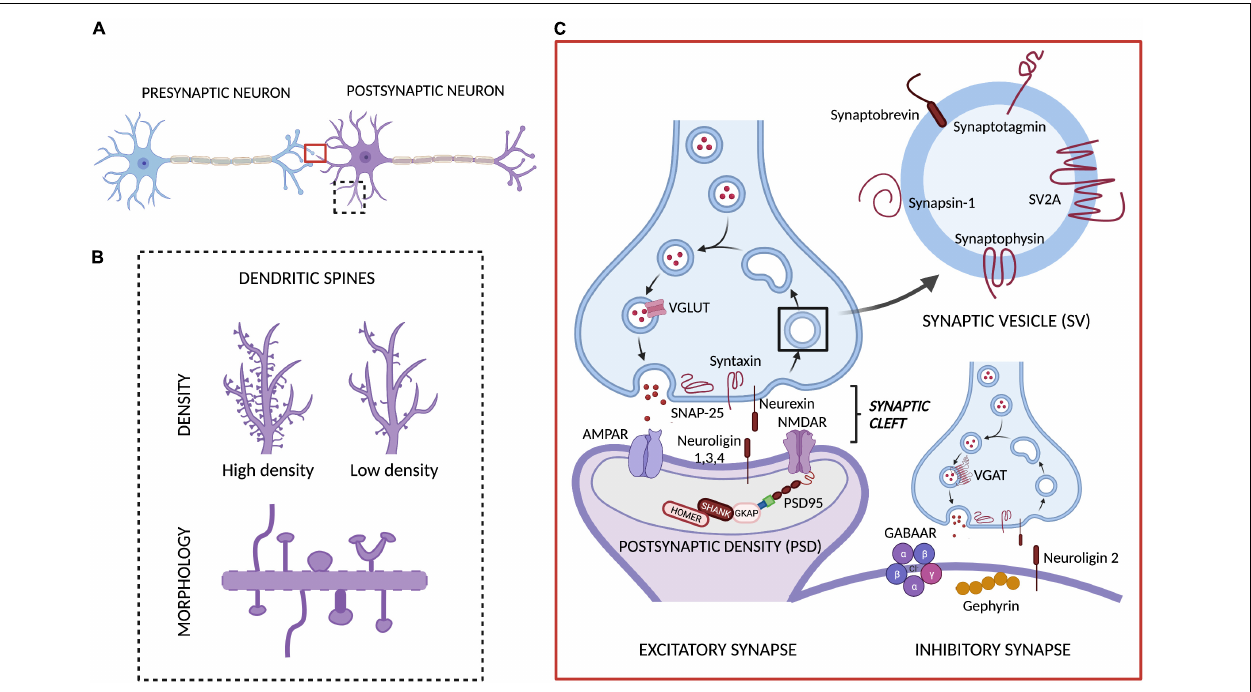
FIGURE 1 | Chemical synapse and targets for measuring synaptic density. (A) The main components of the bipartite synapse: a presynaptic and a postsynaptic neuron, separated by a synaptic cleft. In this synapse we have highlighted the two main targets involved in the methods currently available to quantify or assess synaptic density levels: (B) the dendritic spines (whose density and morphology are typically evaluated with different ex vivo methods) and (C) the proteins involved in synaptic transmission, including synaptic vesicle (SV), presynaptic and postsynaptic proteins present in excitatory and inhibitory synapses (which are quantified through ex vivo and in vivo methods). Adapted from “Synaptic Cleft (Horizontal),” by BioRender.com (2021). Retrieved from https://app.biorender.com/biorender-templates.